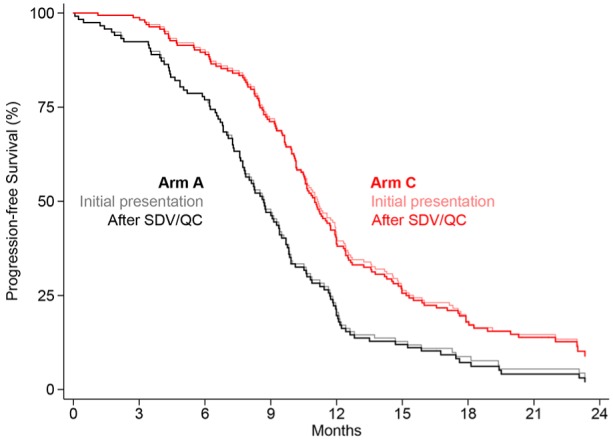
Kaplan–Meier PFS plot displaying estimates of (a) initial presented
results and (b) SDV/QC overlaid.